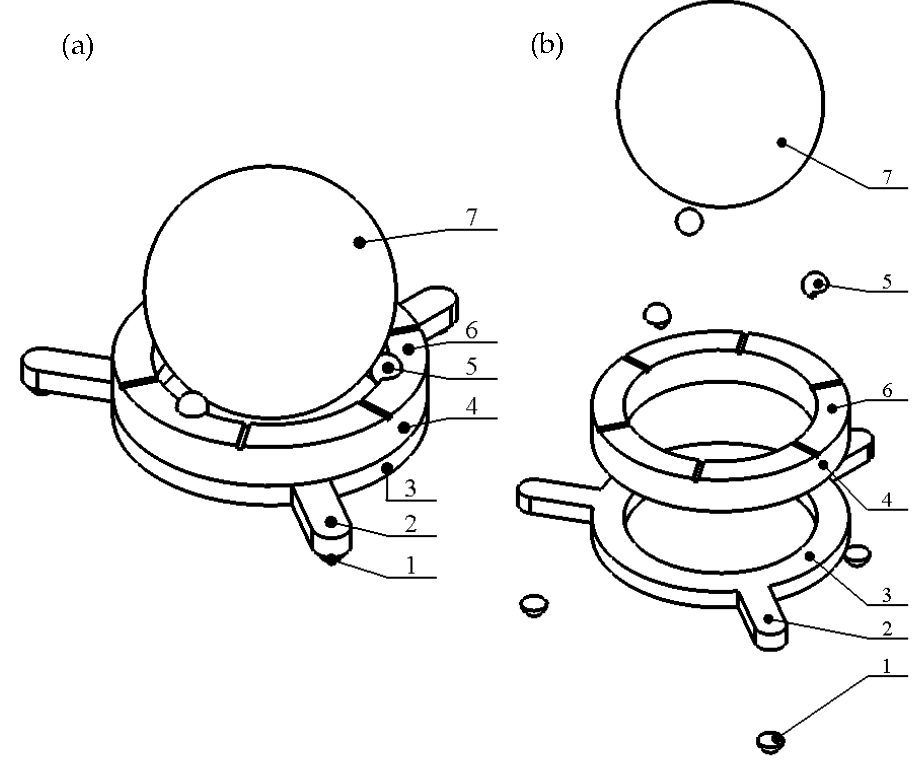
Figure 1. Design of the robot; ( a )—assembled view; ( b )—exploded view; 1—alumina oxide contact for planar motion; 2—spike; 3—ring made from stainless steel; 4—piezo ceramic ring; 5—alumina oxide contact for angular motion; 6—segments of the top electrode; 7—spherical payload.